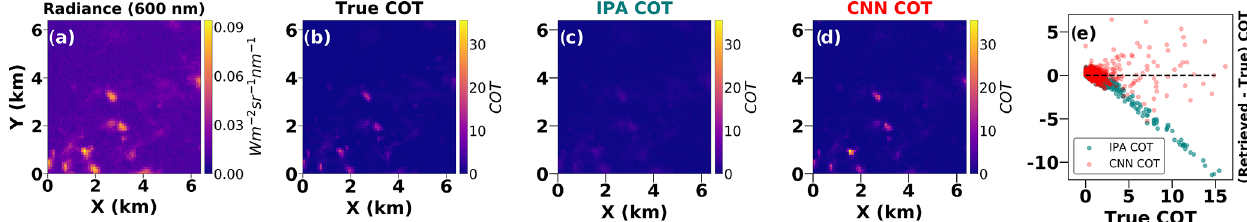
Figure 14. (a) An image of the 64 × 64 (6.4km × 6.4km) radiance channel (600nm) taken from the Atlantic (Sect. 2.1.2) to test the CNN’s ability to generalize to new geographical regions. (b) The corresponding 64 × 64 COT. (c) COT as retrieved by the IPA method of the image in (a) . (d) COT as retrieved by the CNN trained using methods explained in Sect. 4.3. (e) A scatter plot that compares the IPA and CNN retrievals, with the former underestimating for large